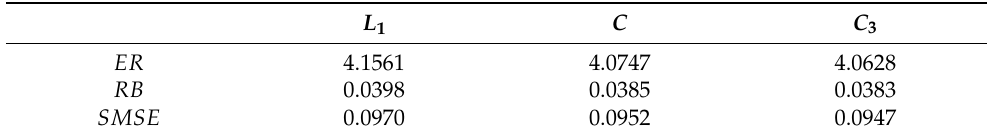
Table 2. Comparisons of the performance between the proposed estimator and other estimators with various risks. L 1 C C 3 ER 4.1561 4.0747 4.0628 RB 0.0398 0.0385 0.0383 SMSE 0.0970 0.0952 0.0947